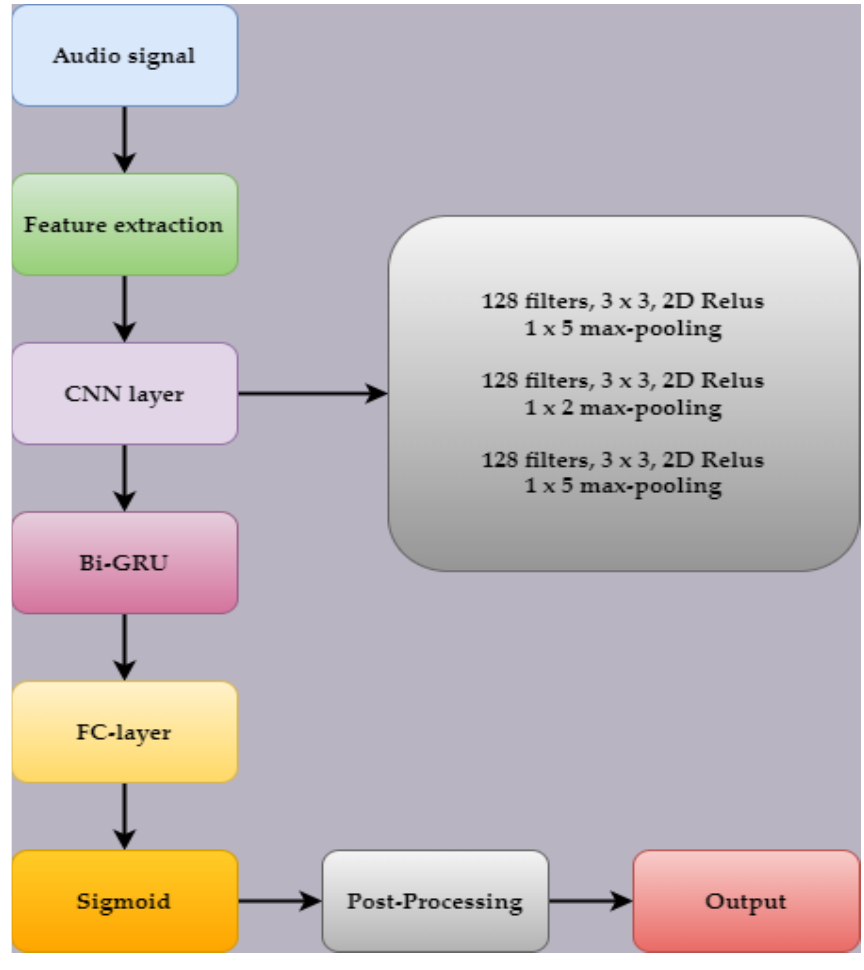
Figure 3. Block diagram of CRNN model .